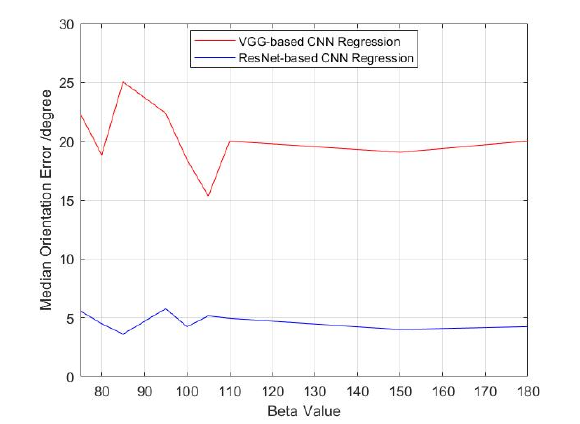
Figure 7. Median orientation error with different β values Figure 6 and figure 7 show that selecting different β values achieves different level accuracy by testing the trained VGG- based CNN architecture and the ResNet-based architecture.